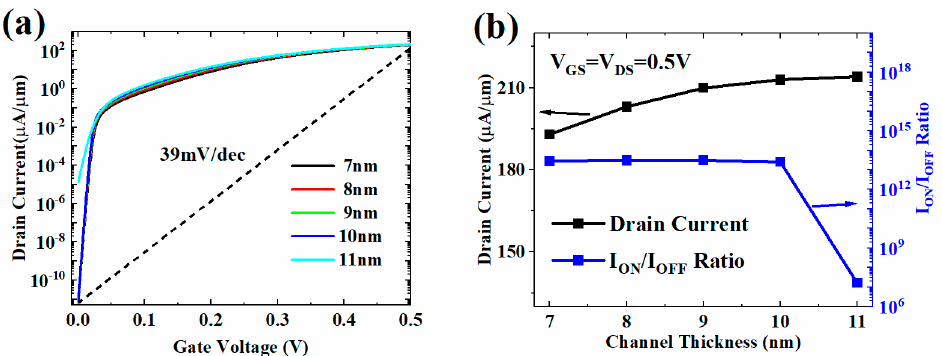
Figure 8. ( a ) Transfer characteristic and ( b ) I ON and I ON / I OFF with different T C values.